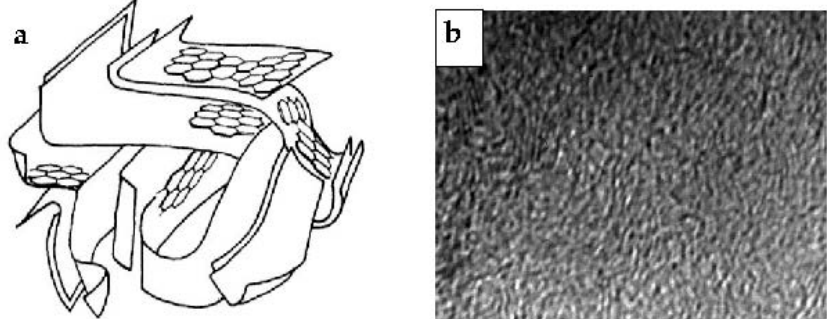
Figure 2. Schematic representation of the structure ( a ). Reproduced from [27] with permission from Elsevier © 1990, and a typical HRTEM image of an AC ( b ).